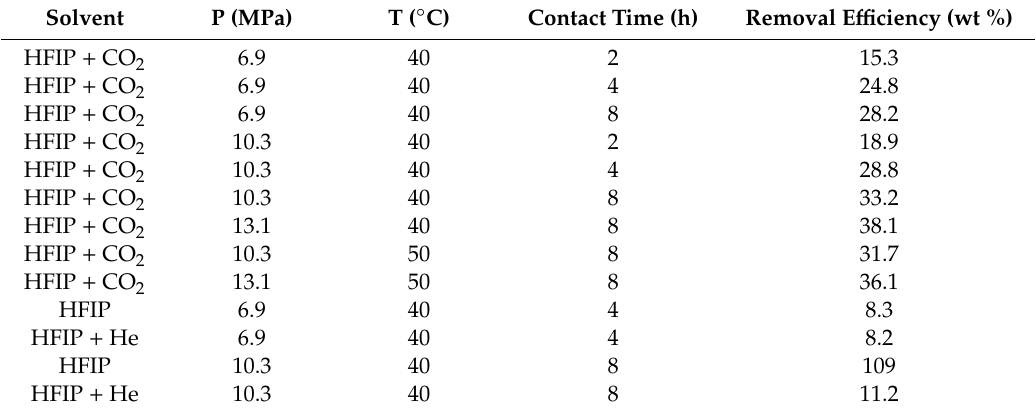
Table 1. Removal e ffi ciency of the cyclic dimer from PBT by the extraction method at various operating